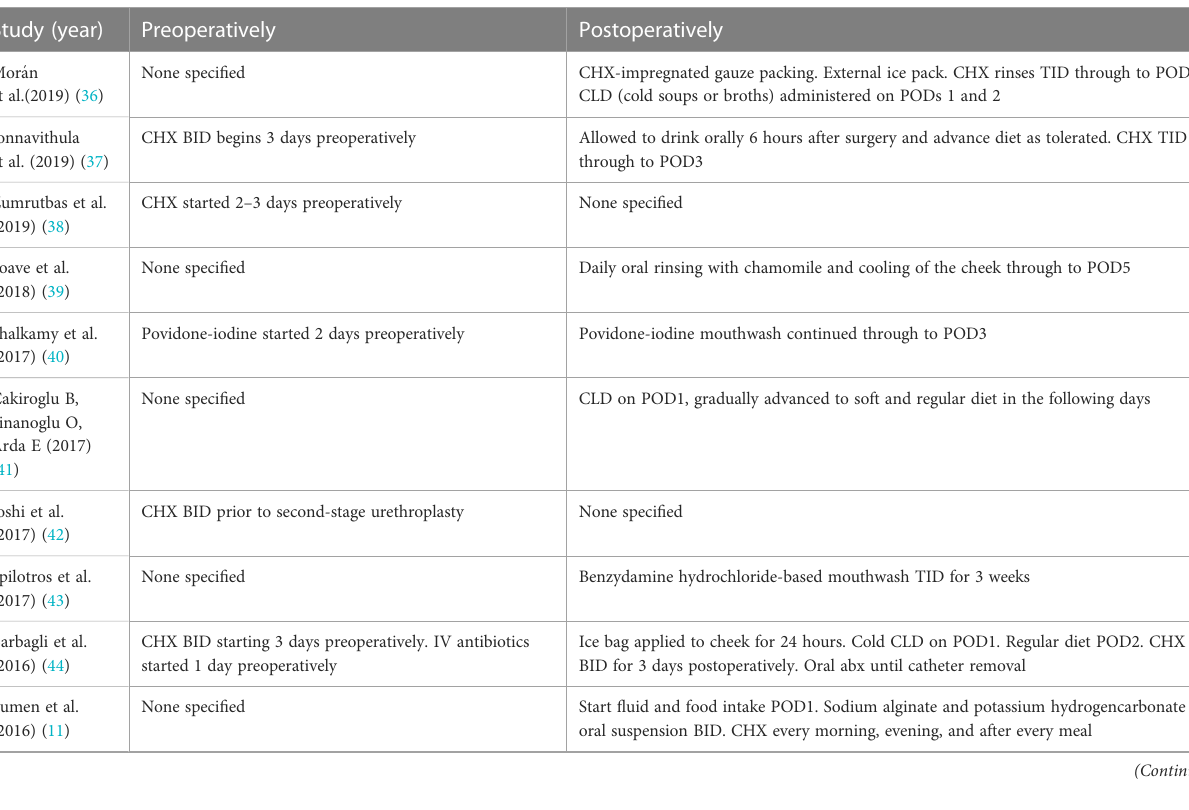
TABLE 2 Variation in BMG harvest oral care pathways. Study